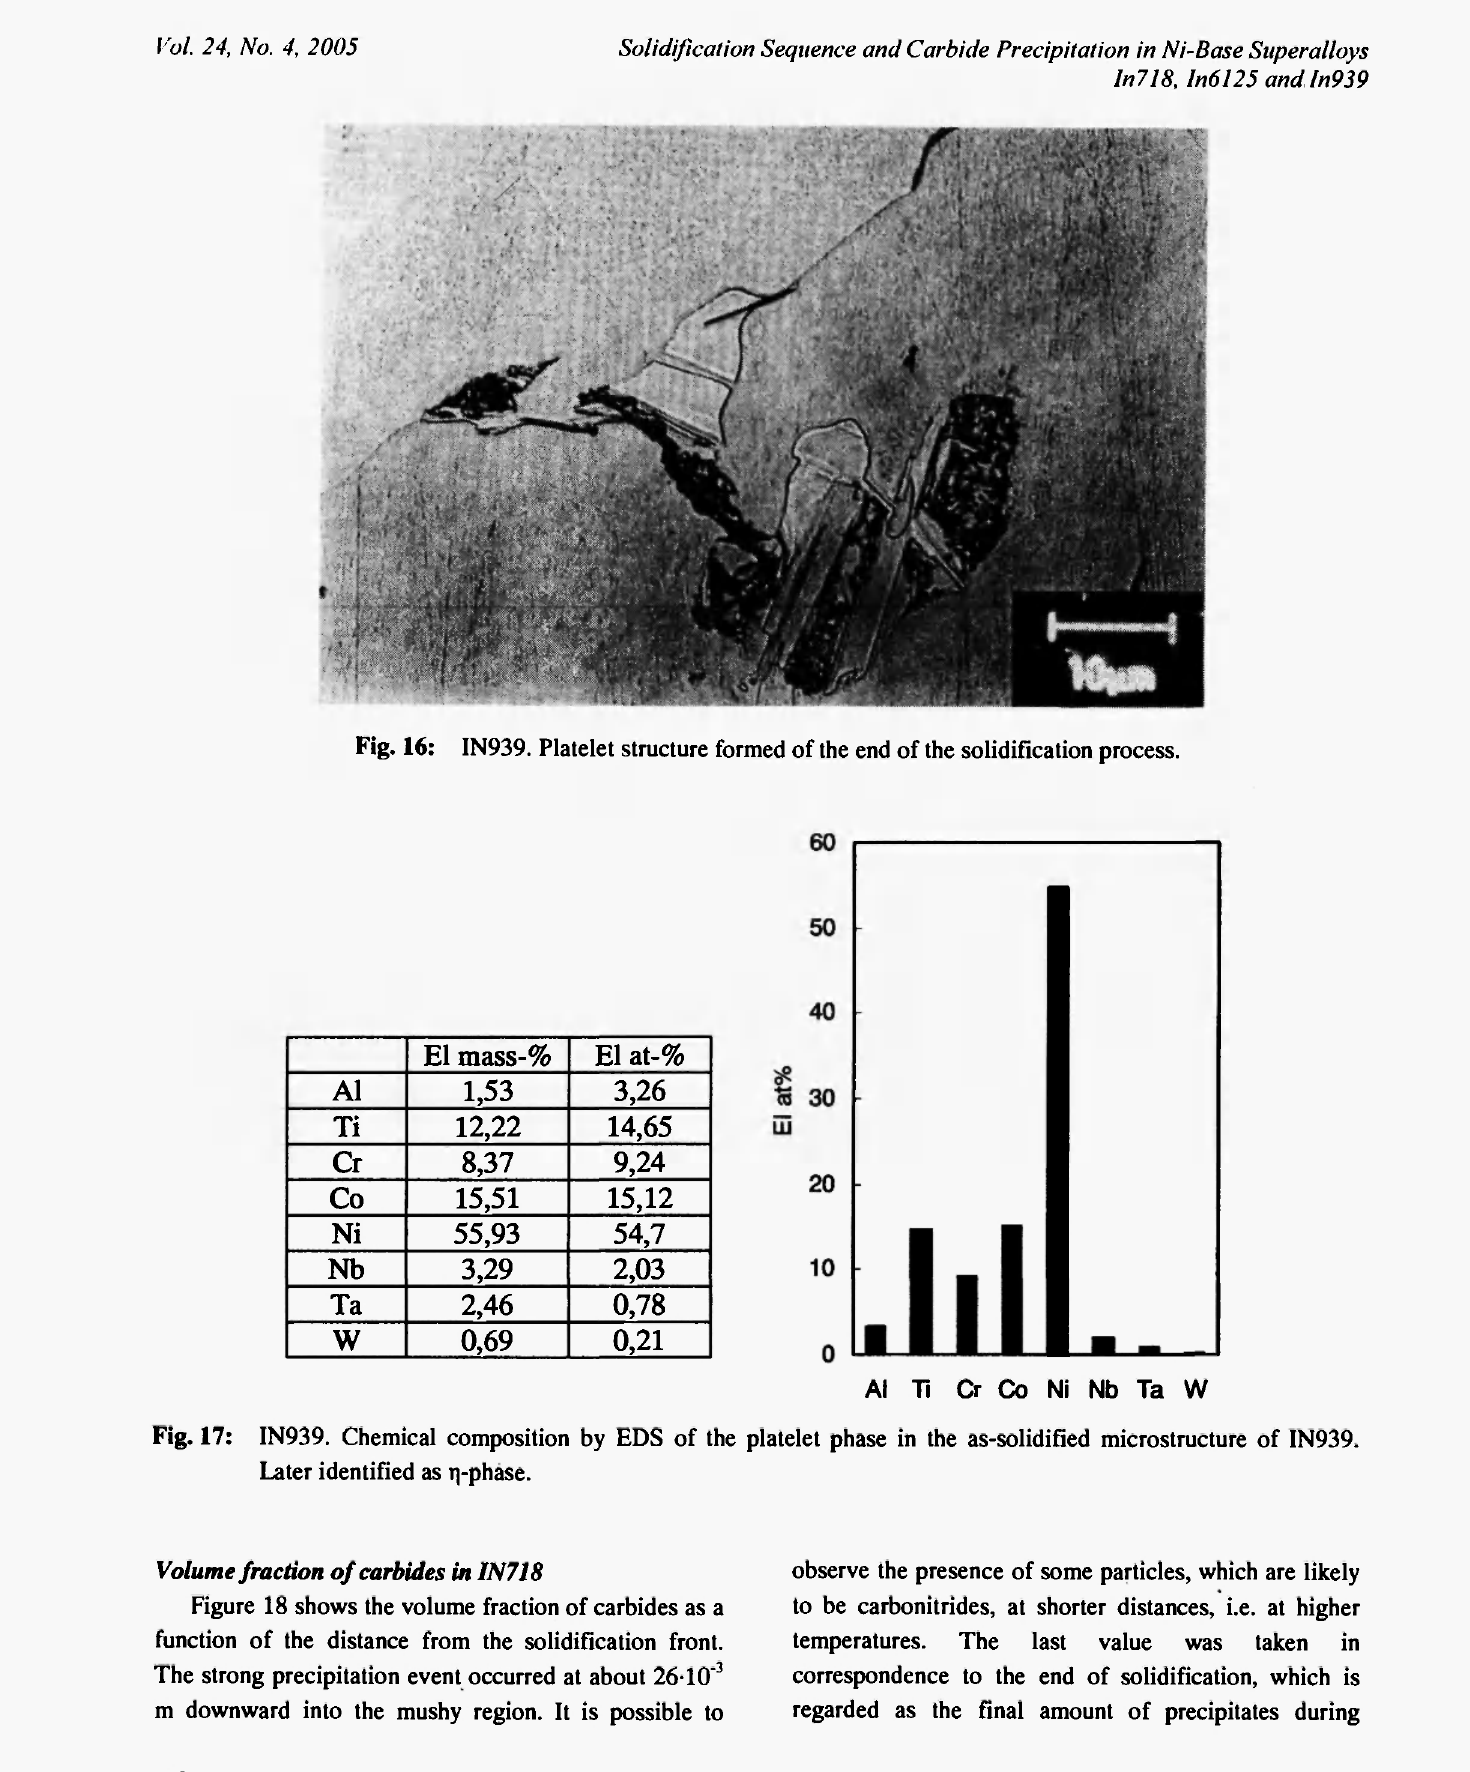
Fig. 17: IN939. Chemical composition by EDS of the platelet phase in the as-solidified microstructure of IN939. Later identified as